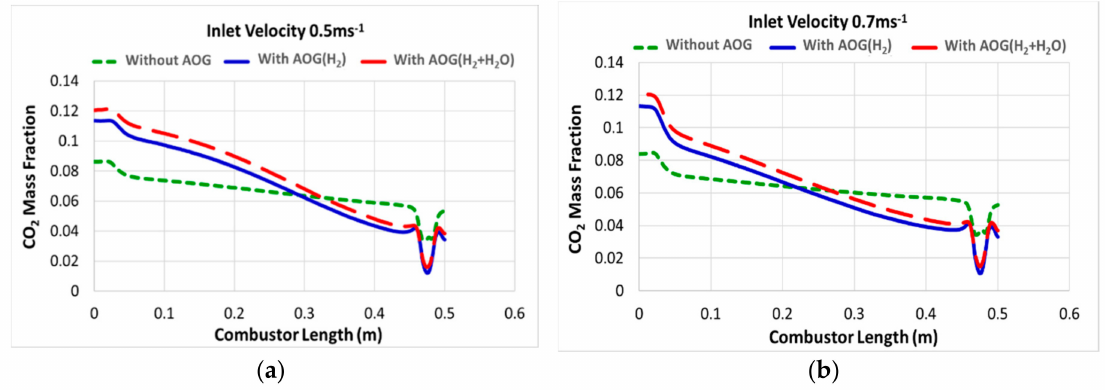
Figure 9. Line plots of CO 2 mass fraction varying as a function of combustor length at ( a ) 0.5 m / s and ( b ) 0.7 m / s inlet velocity for all the three cases.